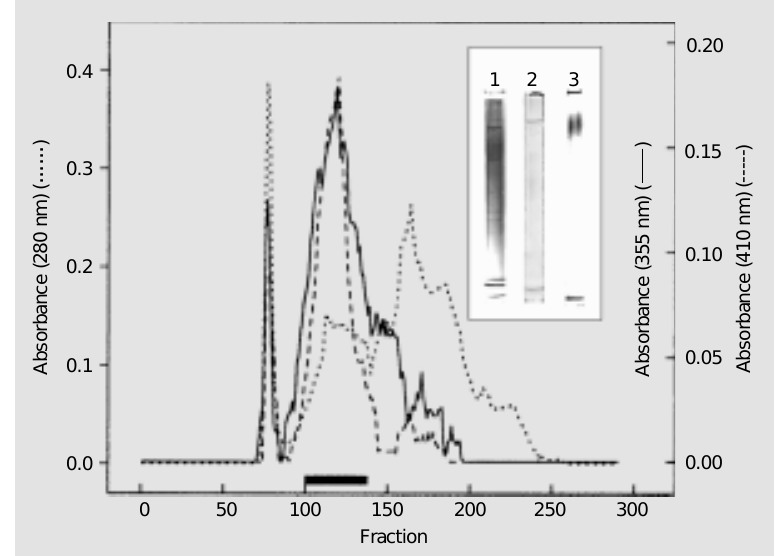
Figure 3. Effect of C 12 E 8 concentration on the solubilization of membrane-bound Na,K- ATPase. Aliquots containing 1 mg of membrane-bound Na,K-ATPase in 20 mM imidazole buffer, pH 6.8, containing 250 mM sucrose, 6 mM Tris and 6 mM EDTA were mixed at 4 (cid:1) C with C 12 E 8 at different concentrations and centrifuged for 1.5 h at 100,000 g using a Hitachi (Model 55P-72) centrifuge. The supernatant was assayed for ATPase activity (filled circles) and solubilized protein (open circles). ATPase, adenosine 5’-triphosphatase; C 12 E 8 , dodecyl-